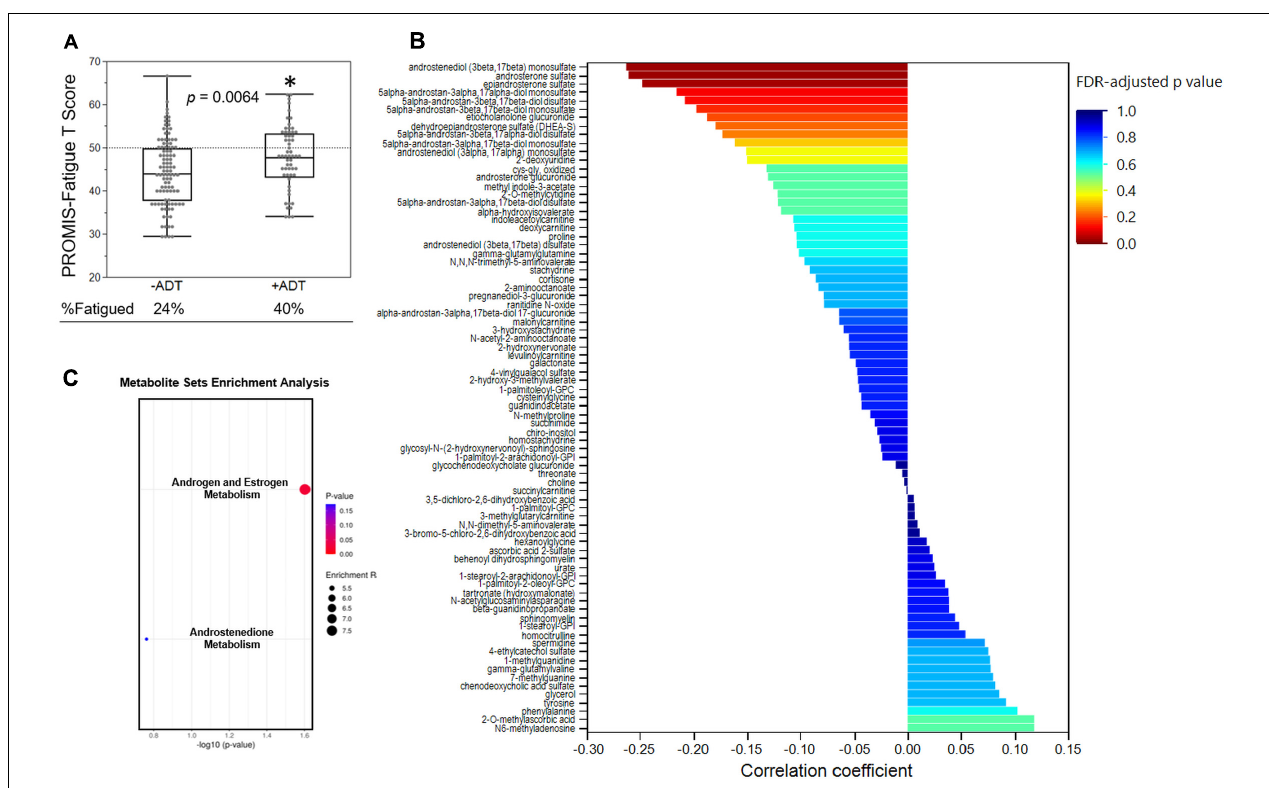
FIGURE 4 | Steroid hormone biosynthesis was associated with fatigue severity. (A) Box plot showing the PROMIS-fatigue T -scores of the − ADT PROMIS-Fatigue T -scores of the − ADT group (44.34 ± 7.81) and the +ADT group (47.92 ± 7.28). *Indicates statistical significance ( p = 0.0064). Scores above the dotted lines are considered fatigued (24% of − ADT, 40% of +ADT). (B) Correlations of PROMIS-Fatigue T -score and metabolites that was significantly different between the two groups. X axis indicates the correlation coefficient. Colors of the bars indicate FDR-adjusted p -values. (C) Metabolite set enrichment analysis of metabolites that significantly correlated with PROMIS-Fatigue T -scores. Steroid hormone biosynthesis (KEGG ID: M00107), including androgen and estrogen metabolism (SMPDB ID: SMP0000068) as well as androstenedione metabolism (SMPDB ID: SMP0030406), were significantly